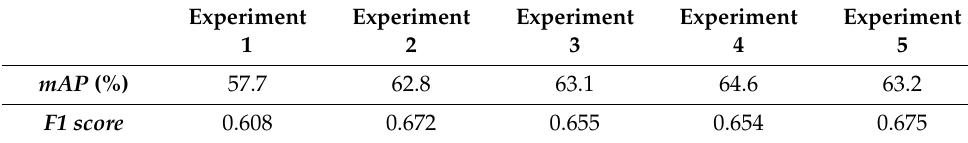
Table 6. Results of YOLOv4-TINY on TT100K dataset.